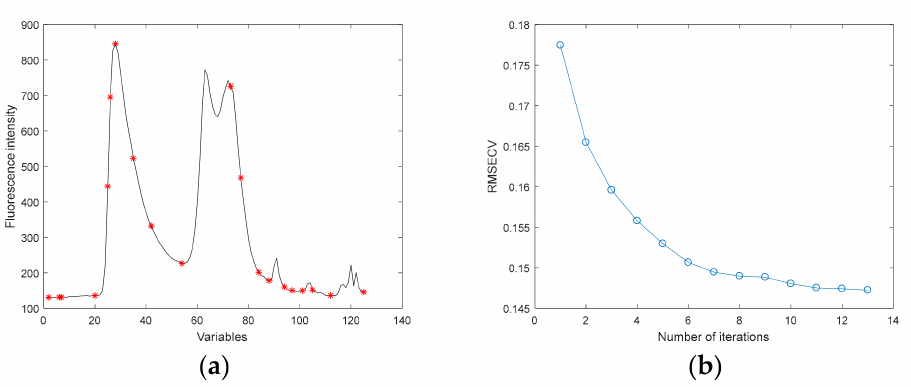
Figure 11. The extracting process of IRIV-VISSA: ( a ) distribution of effective variables; ( b ) the curve of